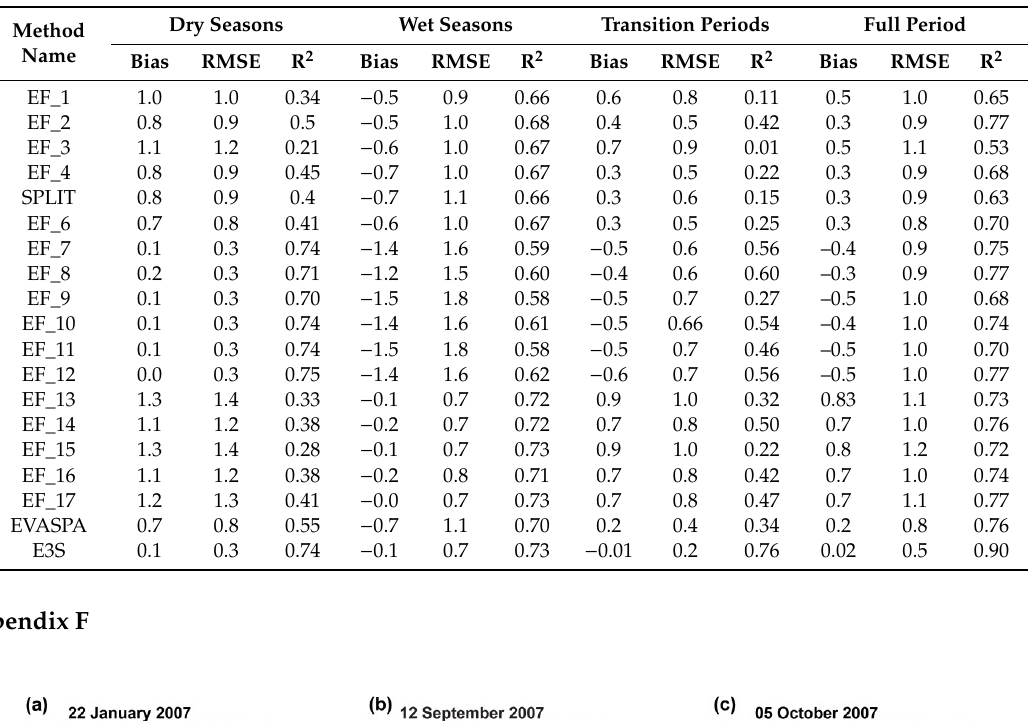
Table A4. Skill scores (Bias and RMSE in mm · day − 1 and R 2 adimensional) of each E3S Ts- α scatterplot edges determination method, EVASPA (unweighted) and E3S (weighted) ensemble mean for blended ET d estimates compared to SiSPAT simulations by seasons.